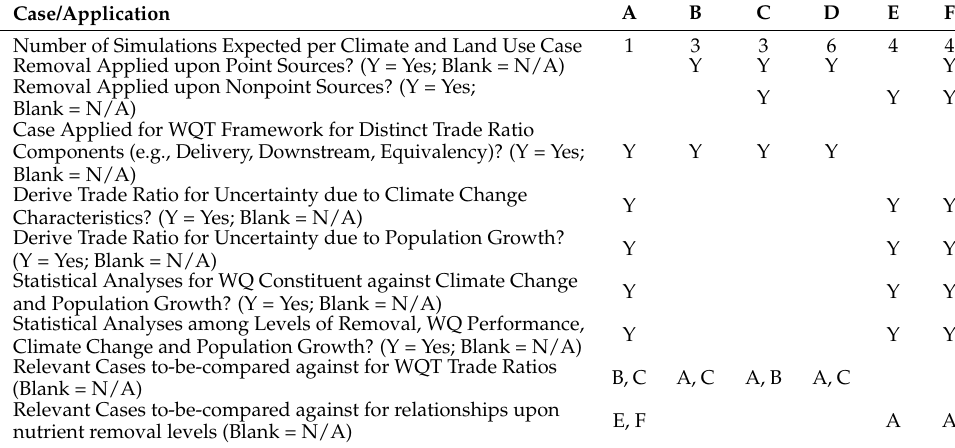
Table 1. Characteristics and Applications for Each Removal and Trading Case.